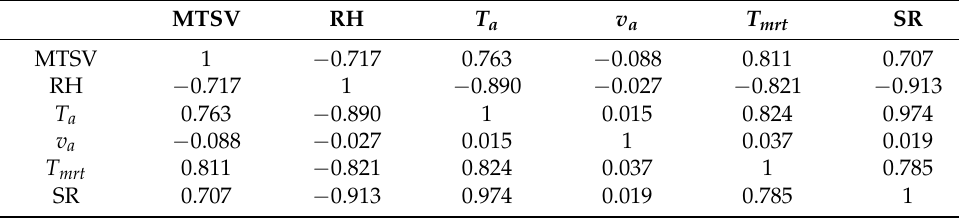
Table 2. Pearson product–moment correlation coefficient